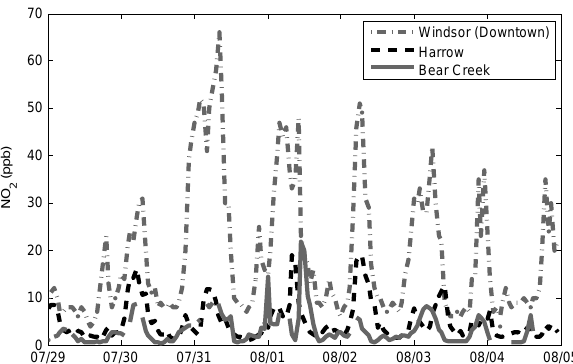
Fig. 5. Comparison of collocated passive and chemiluminescence monitors. X -error bars represent 95% confidence intervals on av- erages from hourly data. Y -error bars represent 95% confidence intervals on averages from approximately 2-week sampling period